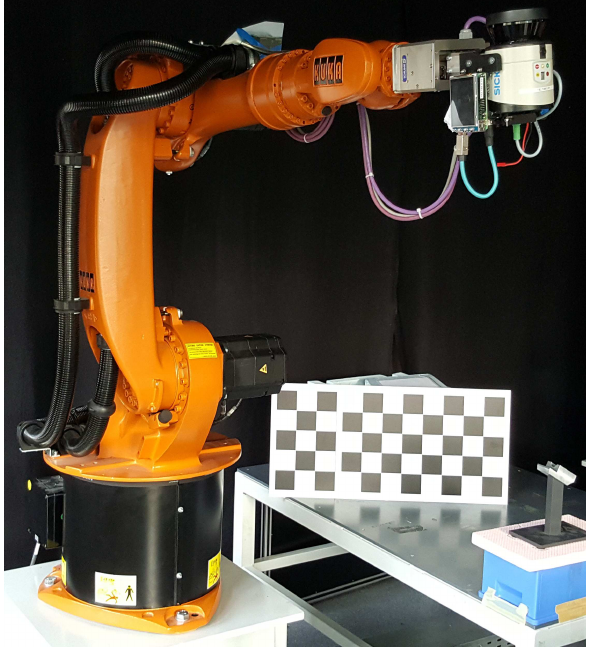
Figure 2. Overview of the test setup - Laser scanner attached to the KUKA KR 16 robotic